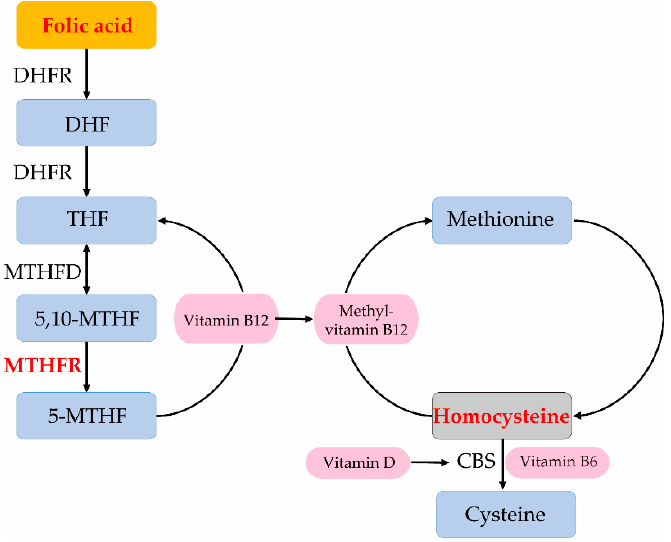
Figure 1. Folic acid and homocysteine metabolic pathway. Folic acid is enzymatically converted to tetrahydrofolate (THF) by dihydrofolate reductase (DHFR) via dihydrofolate (DHF). THF is con- verted to 5,10-methylenetetrahydrofolate (5,10-MTHF) by methylenetetrahydrofolate dehydrogenase (MTHFD) and catalyzed to 5-methyltetrahydrofolate (5-MTHF) by methylenetetrahydrofolate reductase (MTHFR). 5-MTHF can be converted to THF again when a methyl group is passed to vitamin B12, resulting in methyl-vitamin B12. The methyl group can metabolize homocysteine into methionine. Homocysteine is also catabolized to cysteine by a vitamin B6-dependent enzyme, cystathionine β -synthase (CBS). Vitamin D has the effect of enhancing enzyme activity of CBS.